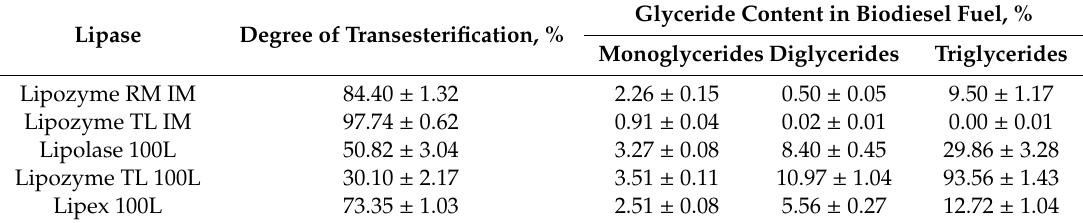
Table 2. Dependence of the degree of transesterification and glyceride content in biodiesel fuel on the di ff erent types of lipases when the oil-to-ethanol molar ratio was 1:5, the duration of reaction was 5 h, the temperature of reaction was 40 ◦ C and the lipase concentration was